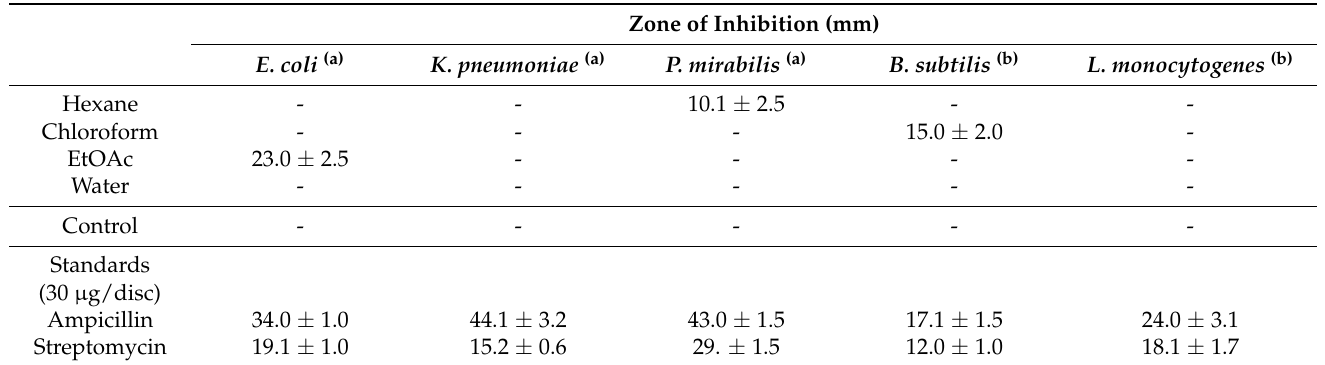
Table 3. Antibacterial activity of the kava root extracts.